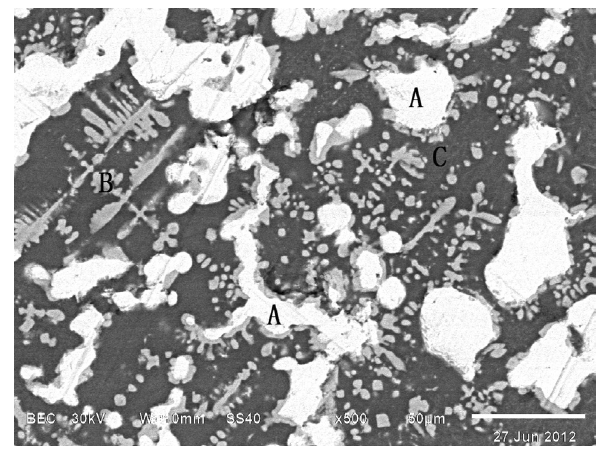
Fig. 8: SEM image of the